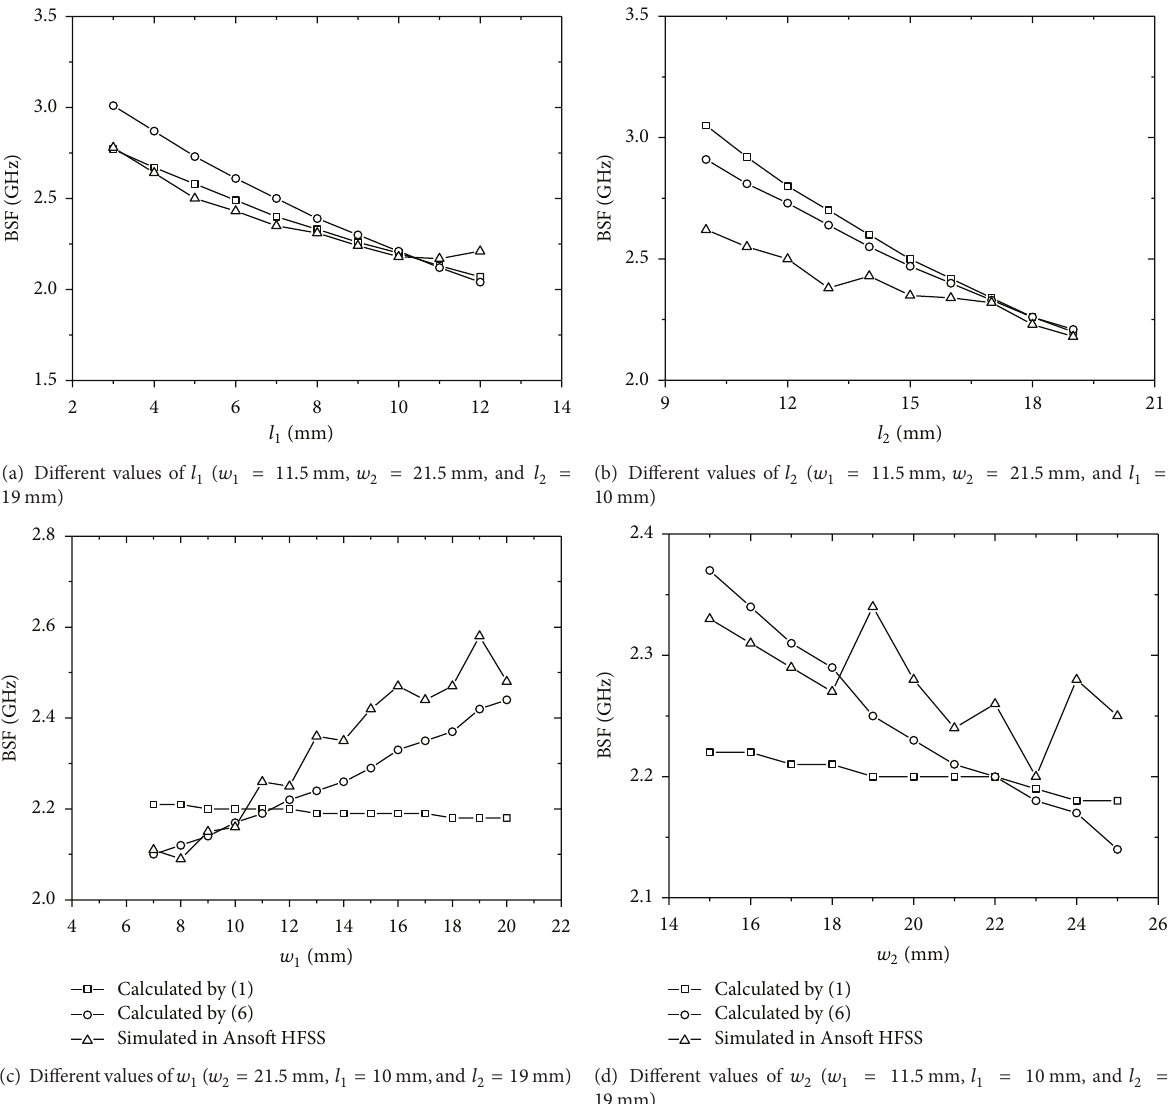
Figure 2: Calculated and simulated BSF for different values of the geometrical